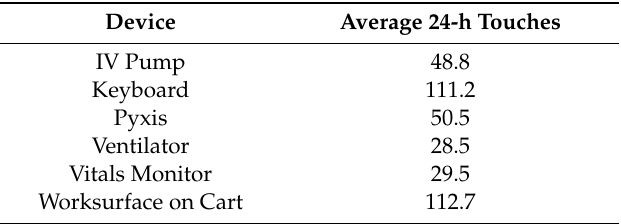
Table 1. Estimated Number of Unique Device Touches per 24-h Period.